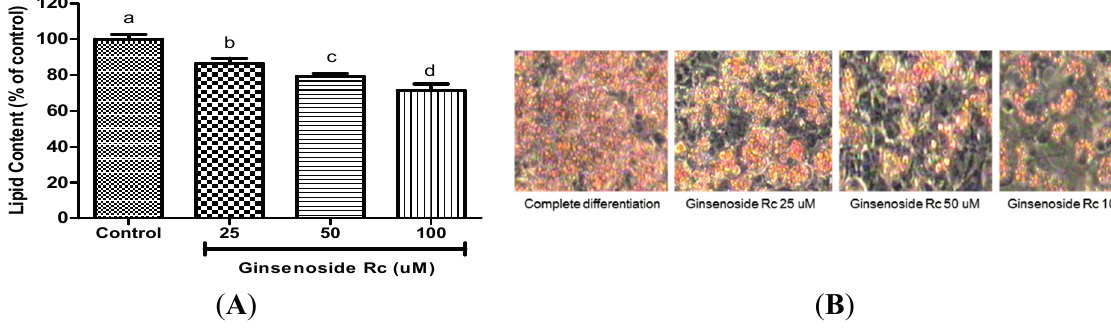
Figure 1. The effects of Rc on adipocyte differentiation ( A ) Post-confluent 3T3-L1 cells were differentiated in the absence or in the presence of Rc. Lipid content was quantified by measuring absorbance. Results are representative of three independent experiments, and statistically significant data are expressed as p < 0.05; ( B ) Lipid droplets were measured by Oil Red O staining. a–d Significant difference in treatment concentrating to ANOVA followed by Duncan ( p <